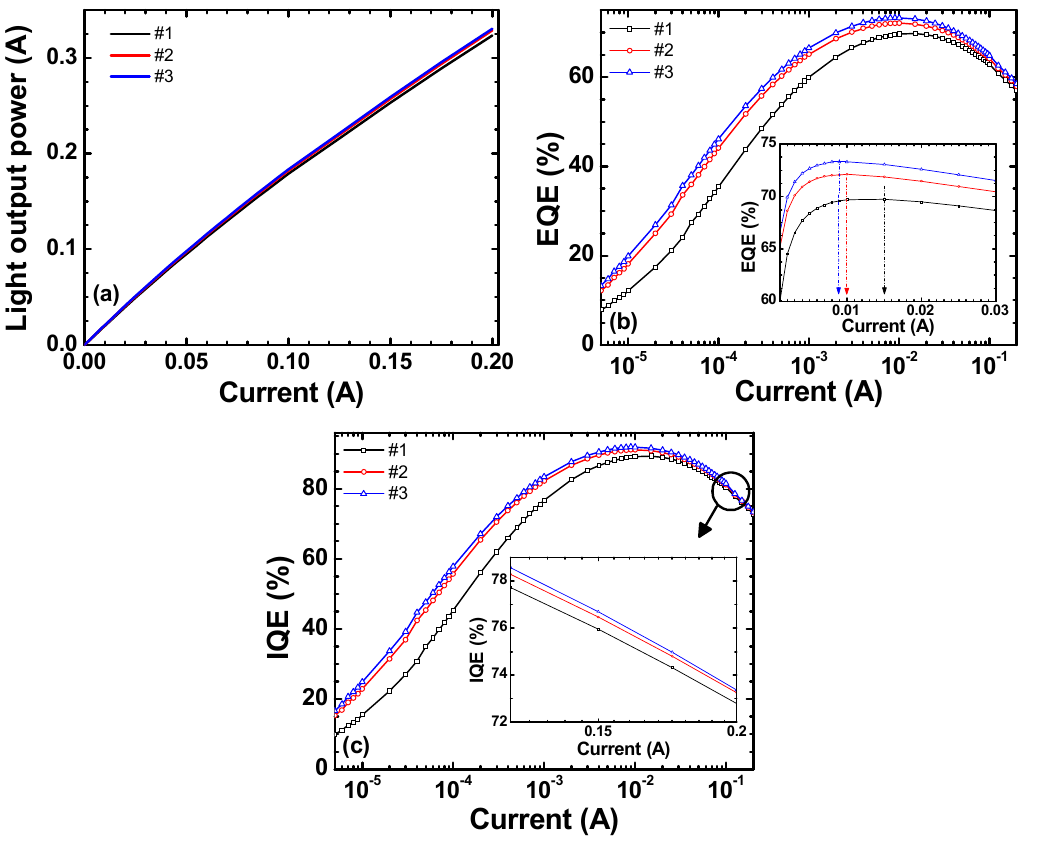
Figure 3. ( a ) L-I characteristics measured at room temperature, ( b ) EQE characteristics as function of current with the inset showing the EQE from 1 to 30 mA, and ( c ) IQE characteristics on semi-log scales. The inset shows the IQEs for the current from 0.125 to 0.200 A.